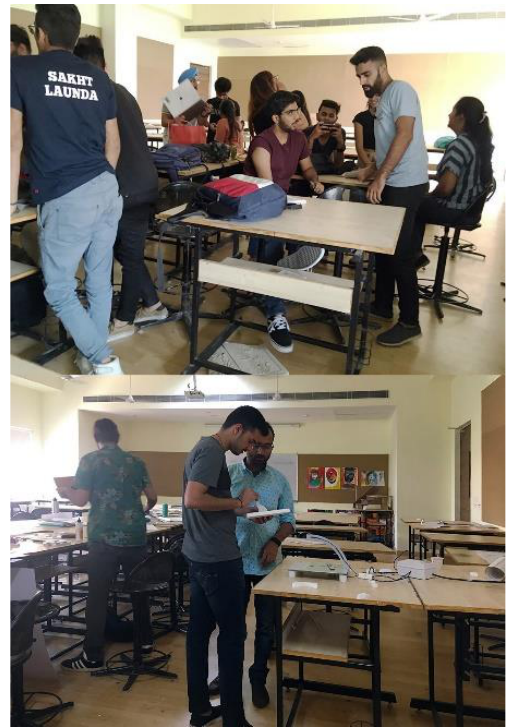
imperative that the nomadic studio is given identity when it is in session to give architecture’s education the special locus that presences its own architecture. Photos